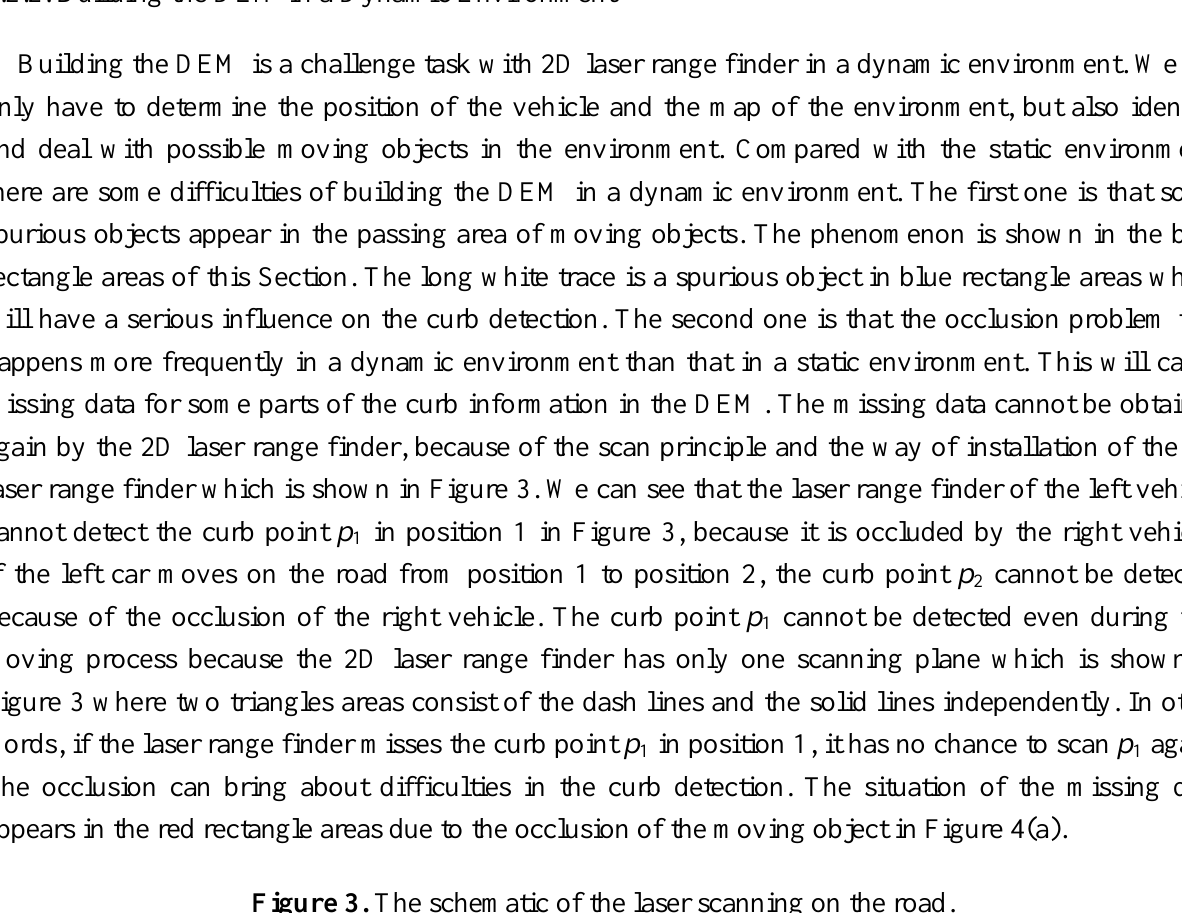
Figure 3. The schematic of the laser scanning on the